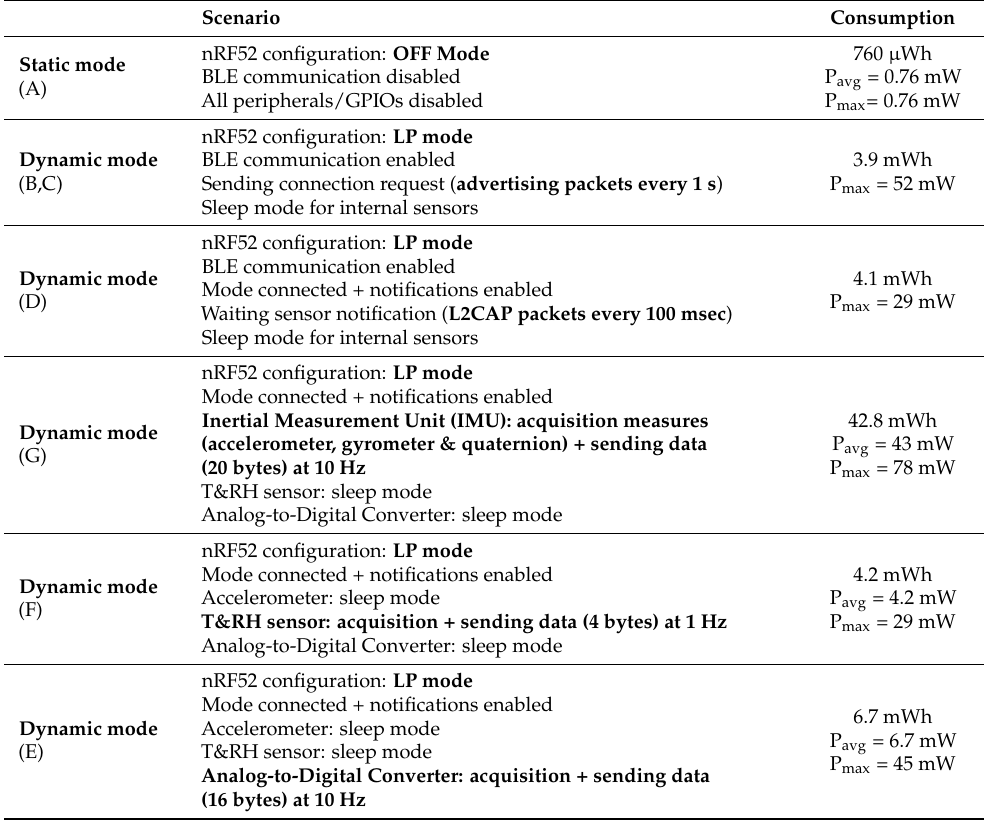
Table 8. Power consumption of embedded sensors on the test platform depending on the scenario: OFF or Low Power (LP) mode. Why does text in the columns not